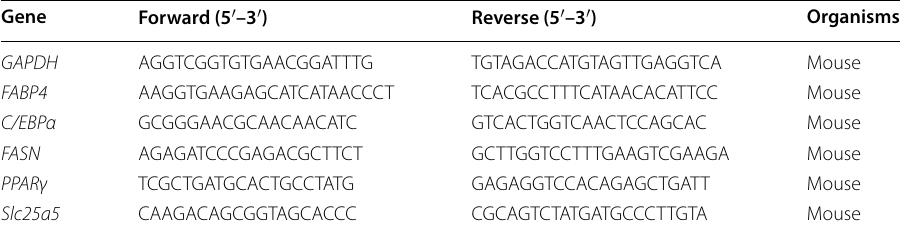
Table 2 Primers for RT-qPCR Gene Forward (5 ′ –3 ′ ) Reverse (5 ′ –3 ′